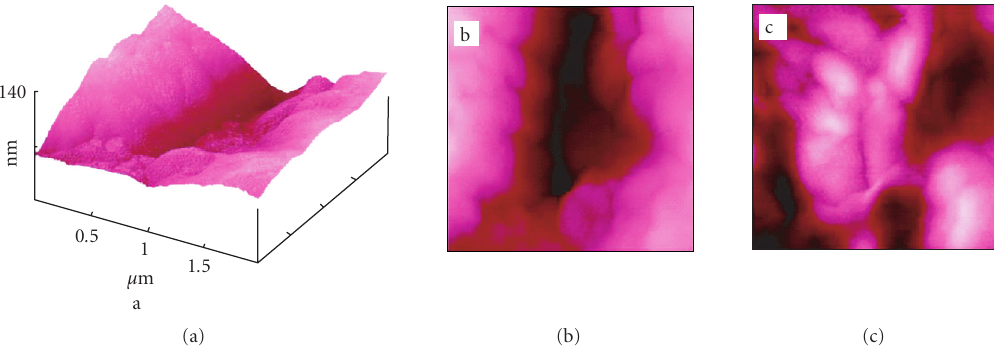
Figure 17: Surface view (a) and top view shear-force AFM (b) of a cryomicrotome cut from a rabbit heart and simultaneous apertureless SNOM (c) showing a lysosome (bottom, dark optical contrast) and mitochondria (bright optical contrast) next to further organelles.